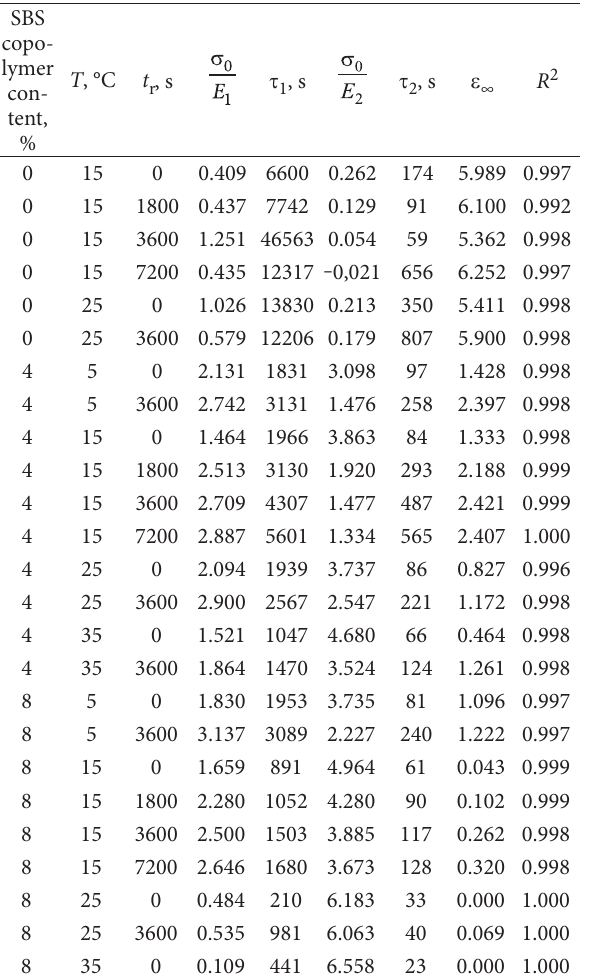
Table 3. Results of modelling of the inverse creep of the tested asphalt binders – parameters of the Dual Kelvin+Newton model SBS copo-